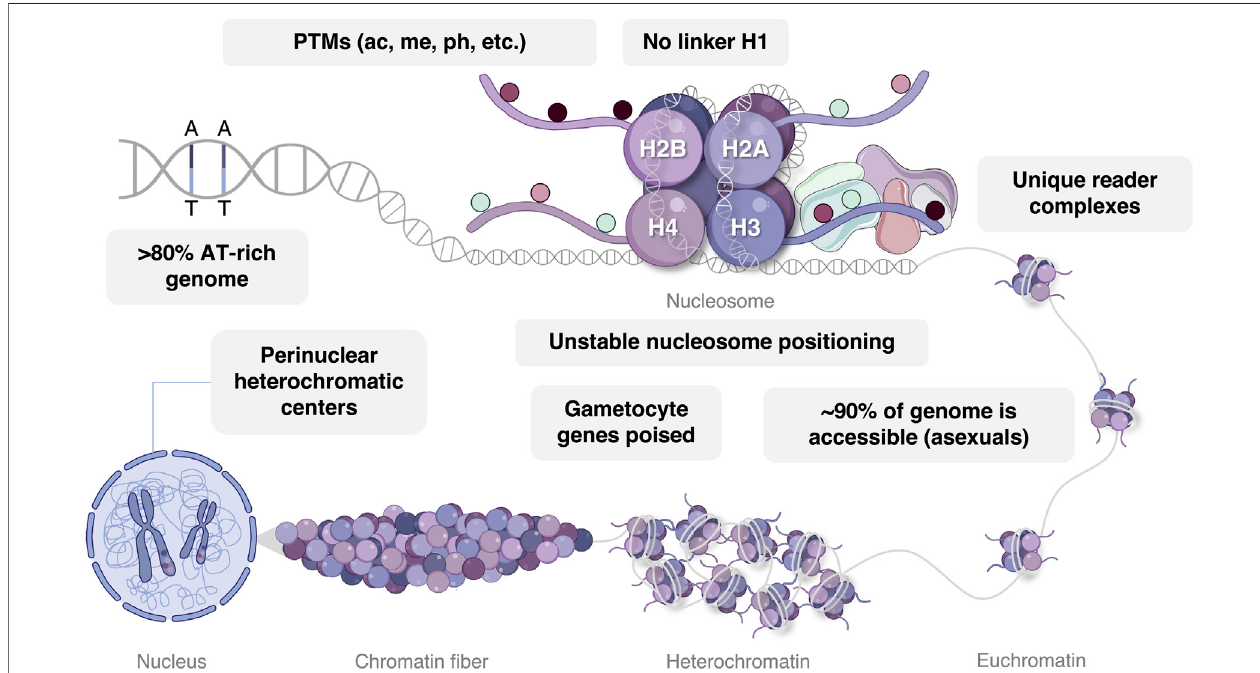
FIGURE 2 | Epigenetic gene regulation in P. falciparum parasites. DNA with an AT bias is wrapped around a nucleosome with conventional eukaryotic histone proteins,including H2A,H2B, H3,and H4. The majority ofhistonepost-translational modi fi cations (PTMs) areread by uniqueepigenetic reader complexesconsisting of somewhat divergent writer and eraser enzymes. In asexual parasites, the majority of chromatin exists in an euchromatic conformational state, while gametocyte chromatinexhibitsanexpansionofH3K9me3-mediatedheterochromatinandisstage-speci fi callypoisedfortranscriptionalactivation.Perinuclearheterochromatic centers reside in the nucleus associated with var gene regulation. Image was created with